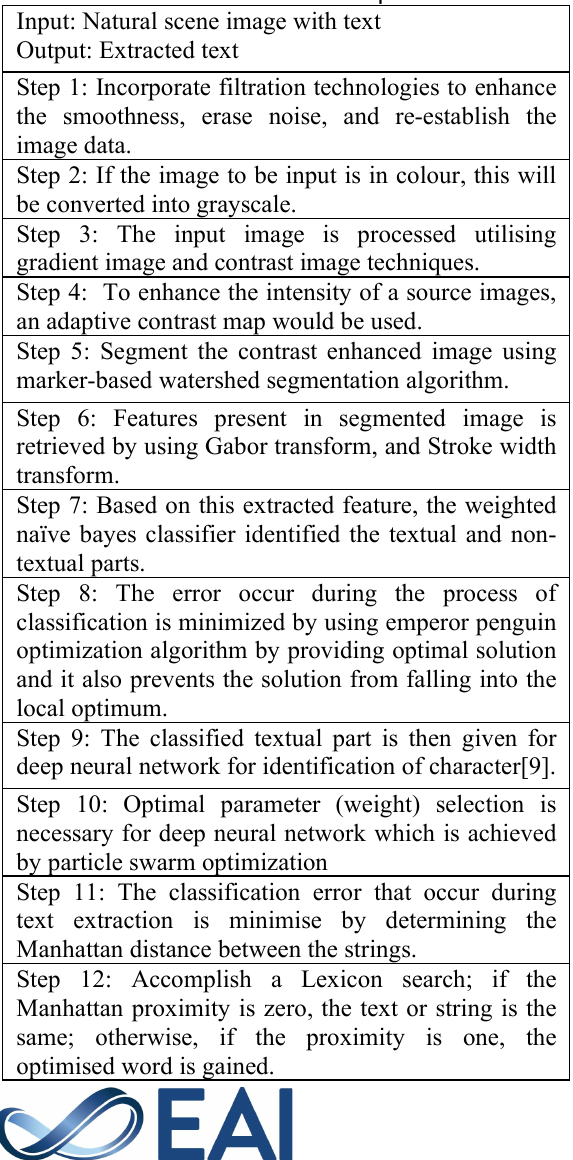
Figure 2. Textual images applied in